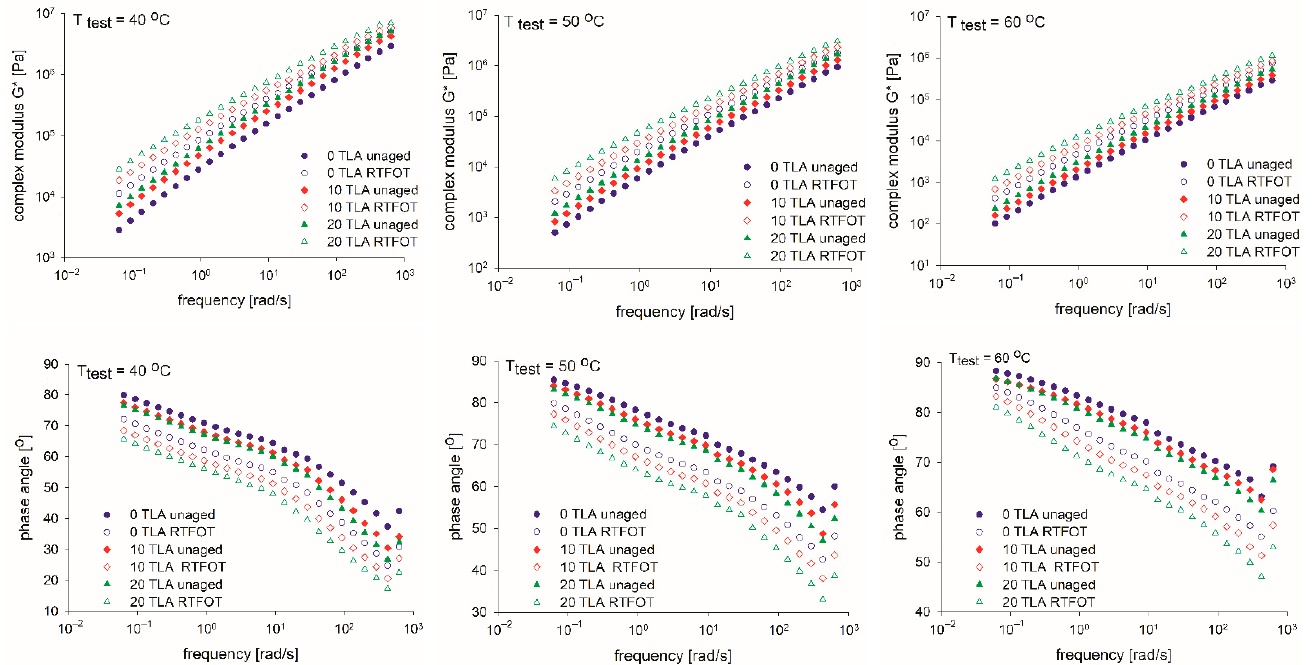
Figure 3. Isothermal curves of the TLA-modified binders before and after the RTFOT aging: complex modulus ( top ) and phase angle ( bottom ) at three specified temperatures: 40 °C, 50 °C, and 60 °C.